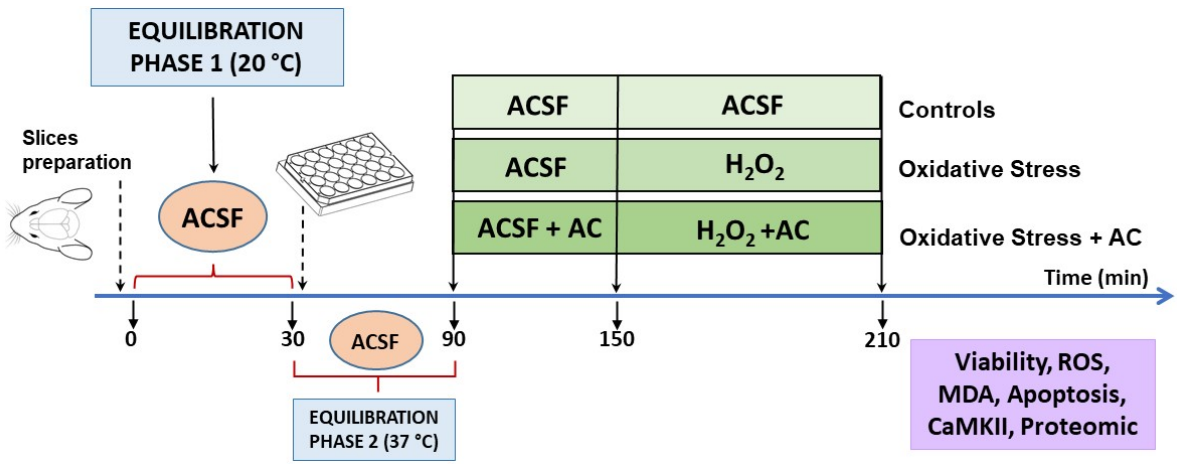
Figure 2. Neuroprotective effects of AC towards hydrogen peroxide-induced injury in rat brain cortical slices: scheme of the experimental protocol used.